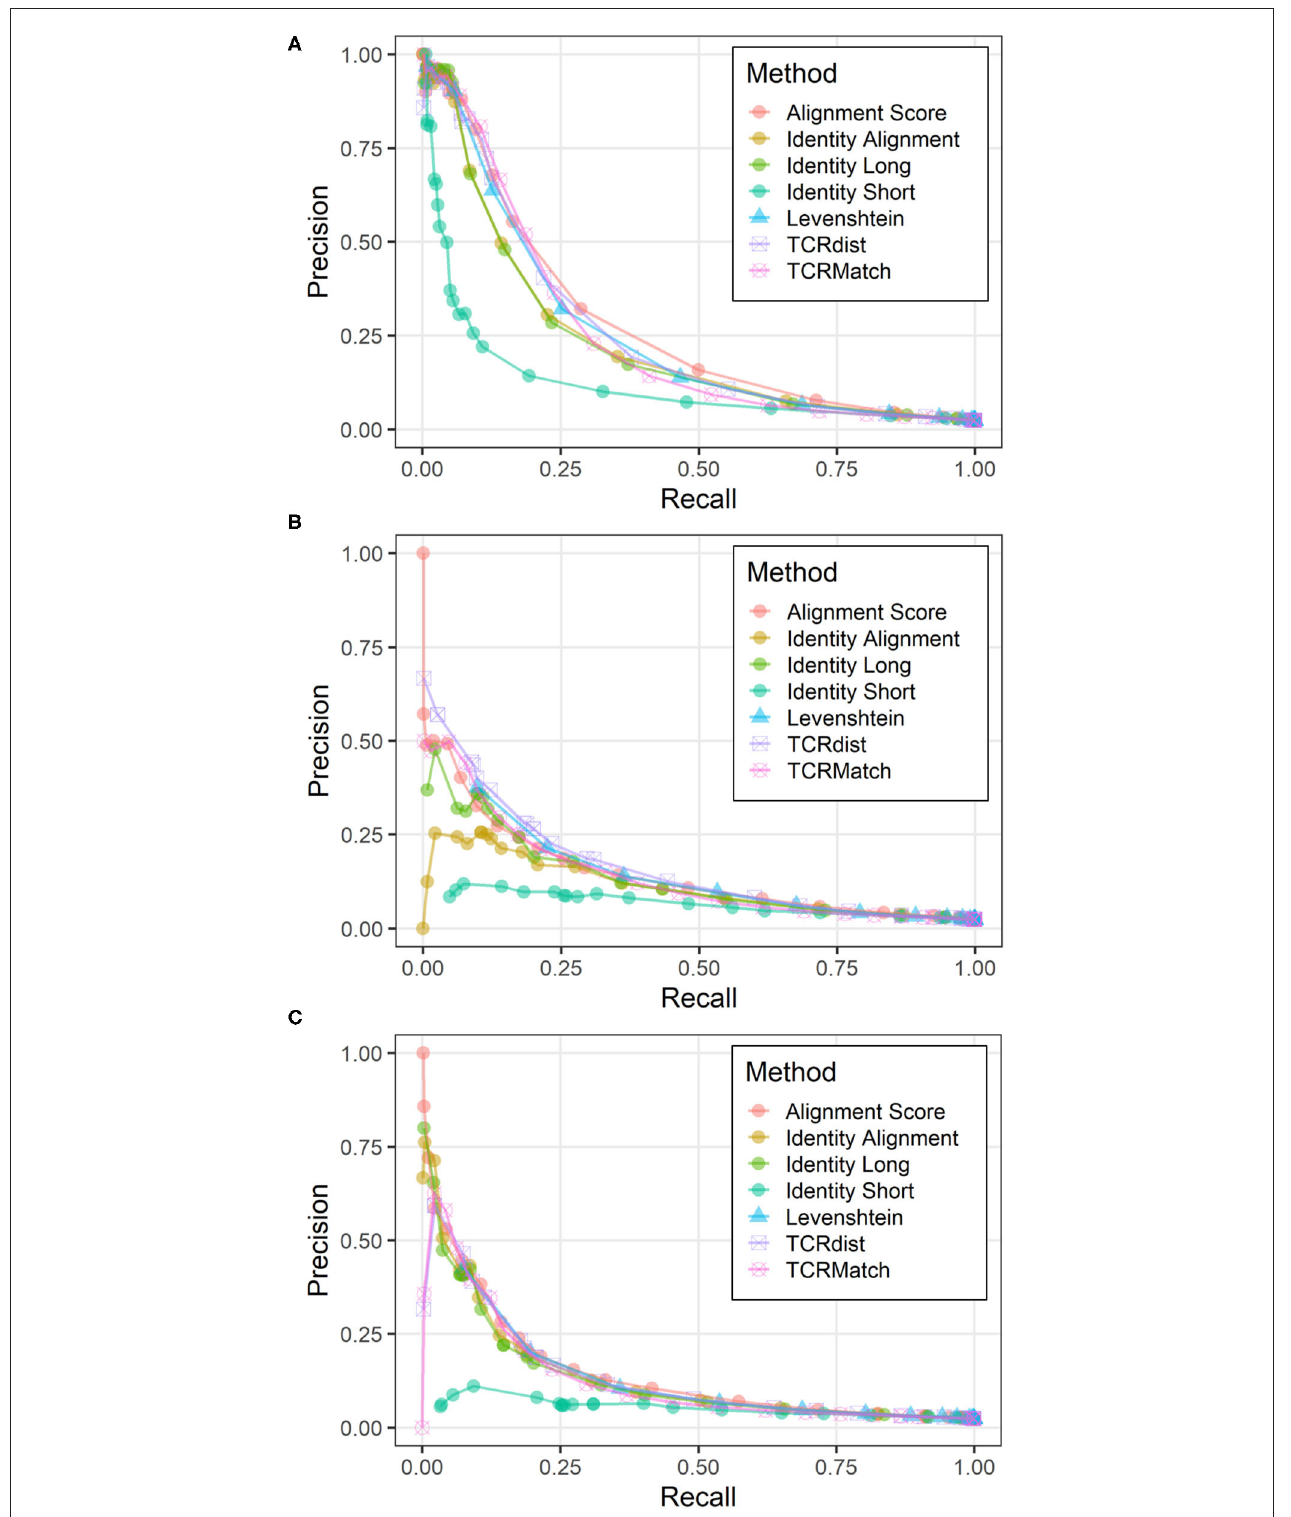
FIGURE 4 | Precision-recall plots comparing performance of sequence similarity metrics on paired CDR3 α -CDR3 β data. Precision and recall were calculated for all seven metrics across similarity thresholds on three related datasets: (A) CDR3 α -CDR3 β pairs, (B) CDR3 α sequences only, and (C) CDR3 β sequences only.